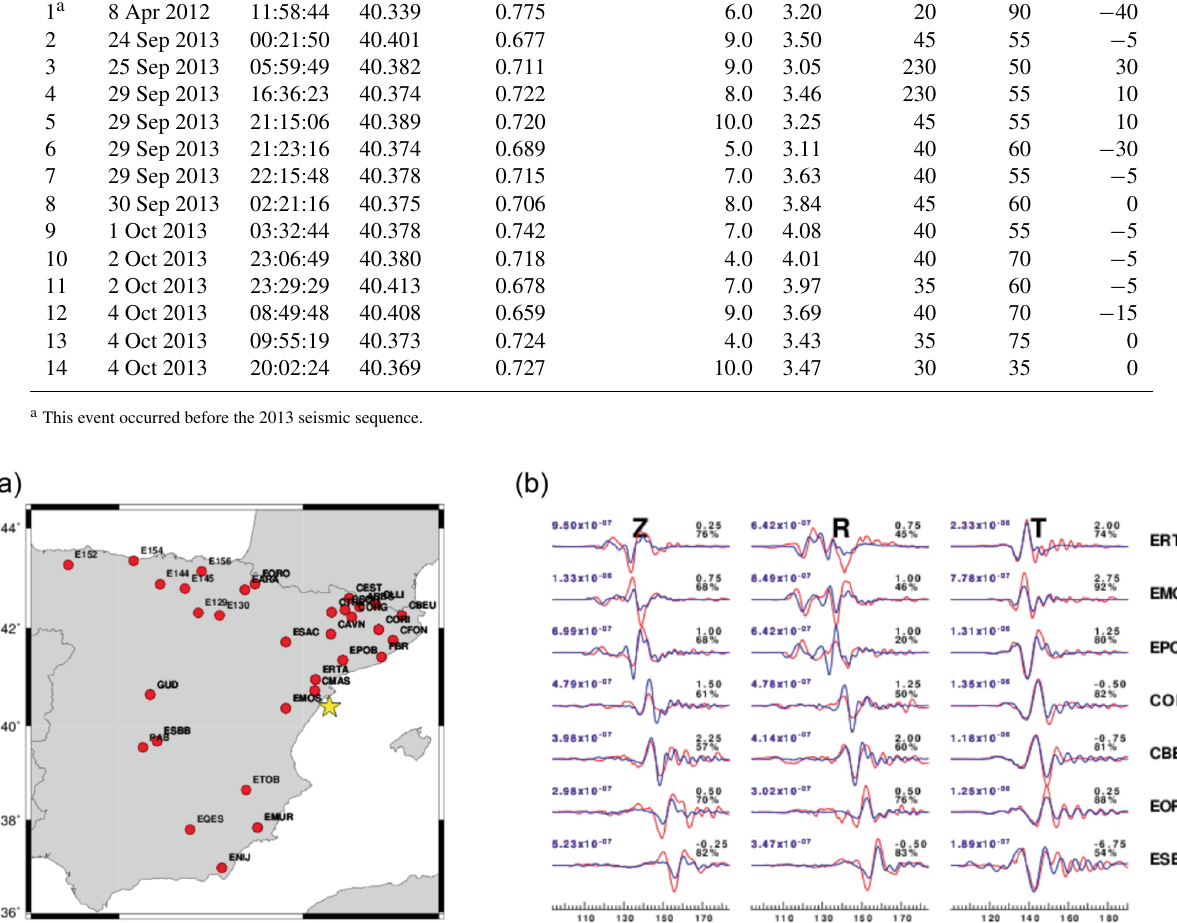
Table 3. Source parameters obtained in this study for the largest earthquakes in the vicinity of the CASTOR gas storage. No.